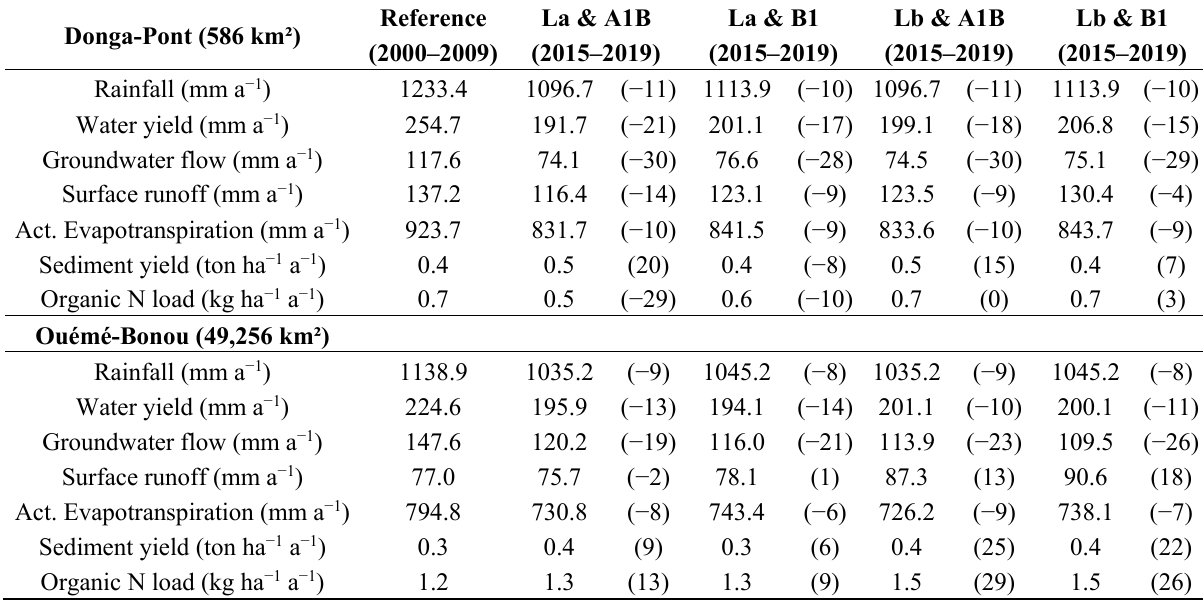
Table 11. Simulated SWAT components under land use and climate scenarios (2015 to 2019). Deviation (in %) from the reference scenario (2000–2009) are shown in brackets.